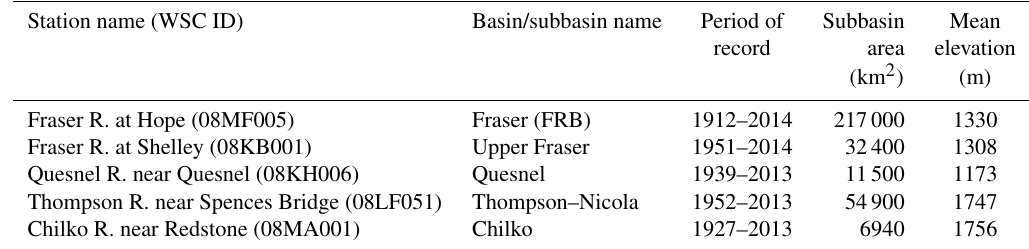
Table 1. Water Survey of Canada (WSC) hydrometric stations and corresponding basin and subbasin characteristics. Station name (WSC